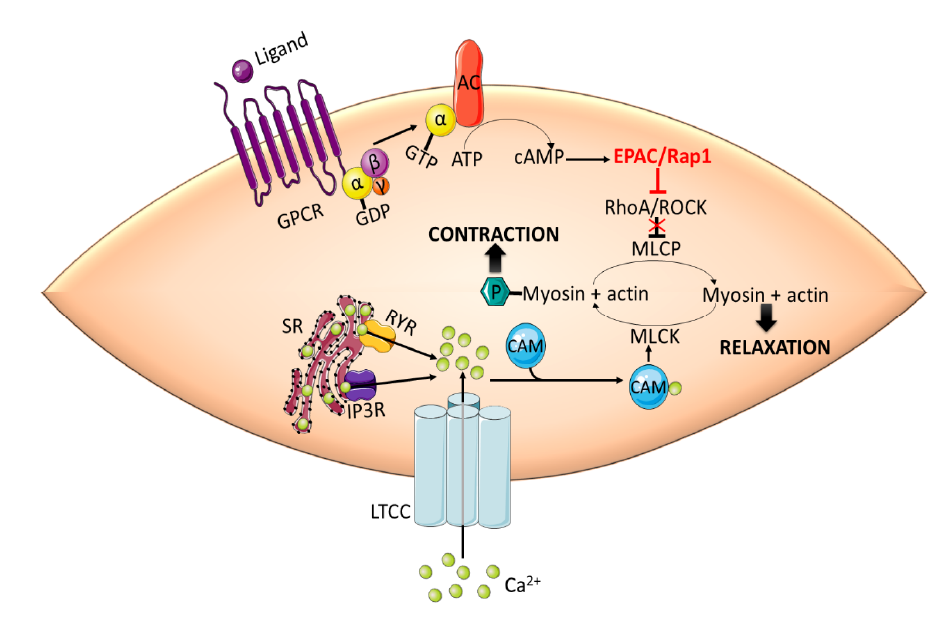
Figure 2. EPAC promotes vasorelaxation in vascular smooth muscle cells (VSMCs) by inhibiting RhoA / ROCK signaling. Activation of RhoA / ROCK phosphorylates MLCP and inhibits its phosphatase activity. This in turn increases the phosphorylation of MLC by MLCK, which is activated by Ca 2 + -CaM complex, and induces contraction. cAMP-mediated activation of EPAC / Rap1 releases the inhibitory e ff ect of RhoA / ROCK on MLCP leading to the dephosphorylation of MLC and subsequent relaxation. CaM: calmodulin; GPCR: G-protein coupled receptor; IP3R: inositol 1,4,5-triphosphate receptor; LTCC: L-type calcium channel; MLC: myosin light chain; MLCK: myosin light chain kinase; RYR: ryanodine receptor; SR: sarcoplasmic